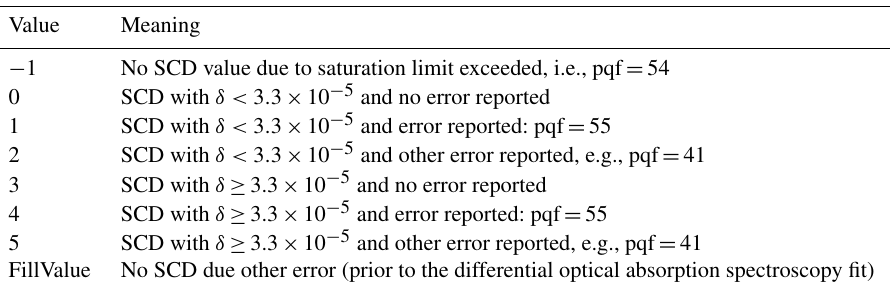
Table A1. Definition of